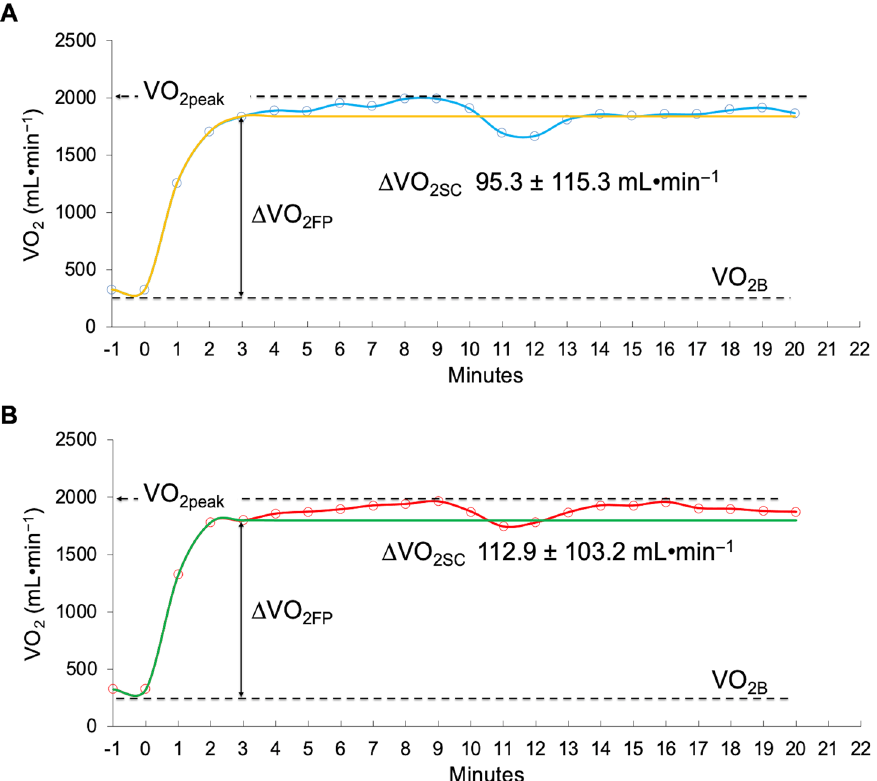
Figure 1. Slow component of oxygen uptake ( VO 2sc ): ( A ) Aerobic dance on an air dissipation platform (blue line: VO 2sc of participants ; yellow line: VO 2sc expected at VT 1 ) ( B ) Constant speed treadmill test at VT1 intensity (red line: VO 2sc of participants; green line: VO 2sc expected at VT 1 ). Abbreviations: ∆ VO 2FP = increase in oxygen uptake in the fundamental phase; VO 2B = baseline oxygen consumption.